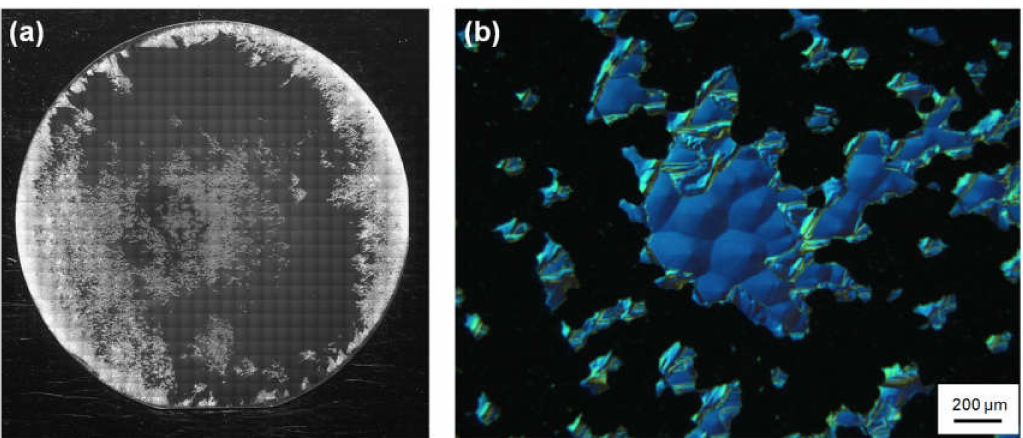
Figure 5. ( a ) PL image of the on-axis 4H-SiC homoepitaxial layer grown on the 3-inch substrate at the growth rate and ramp-up time of 40 µ m / h and 5 min, respectively, and ( b ) NOM image at the central region.